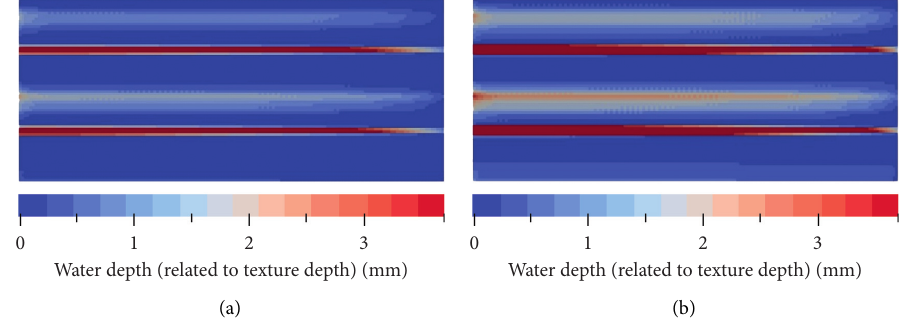
Figure 9: Example 2: effects of different rain intensities i on the drainage of a pavement surface with ruts (rut depth and geometry after 30 years). (a) i � 0.75mm/min, duration 15min. (b) i � 2.0mm/min, duration 15min.